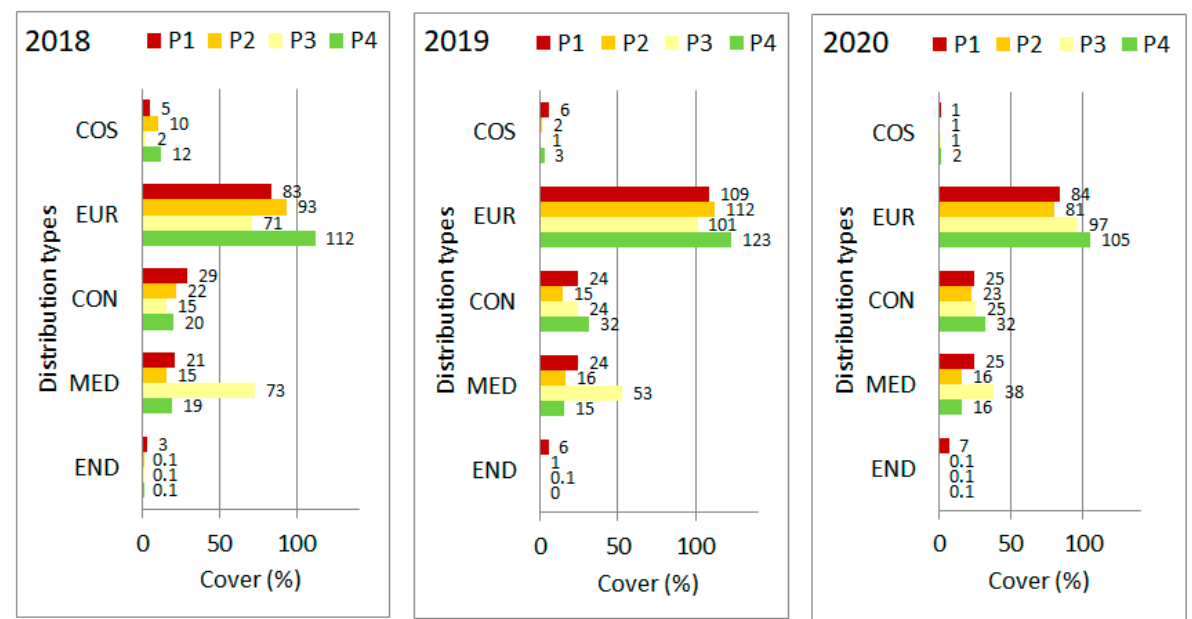
Figure 4. Share among distribution range types based on species’ cover values in the four plots (P1–P4) of “Pócalja” Natura 2000 loess grassland (Central Hungary), in years 2018, 2019 and 2020. COS = cosmopolitan, EUR = European, CON = continental, MED = Mediterranean, END = endemic.